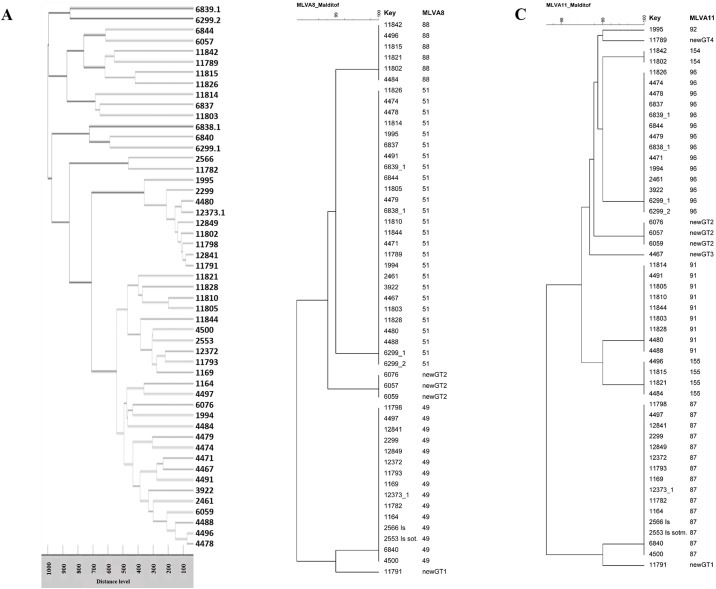
Representative dendrograms of the MALDI-TOF, MLVA-8 and MLVA-11 assays.MALDI-TOF dendrogram of 51 selected B. melitensis field strains from Italy (A). Unweighted pair group method with arithmetic mean assessments of the relationships between the 51 B. melitensis isolates using MLVA-8 (B) and MLVA-11 (C) data. Each strain is individuated by an identification number and genotype. Genotype designations followed the nomenclature used in the international MLVA database (http://mlva.u-psud.fr/mlvav4/genotyping/).